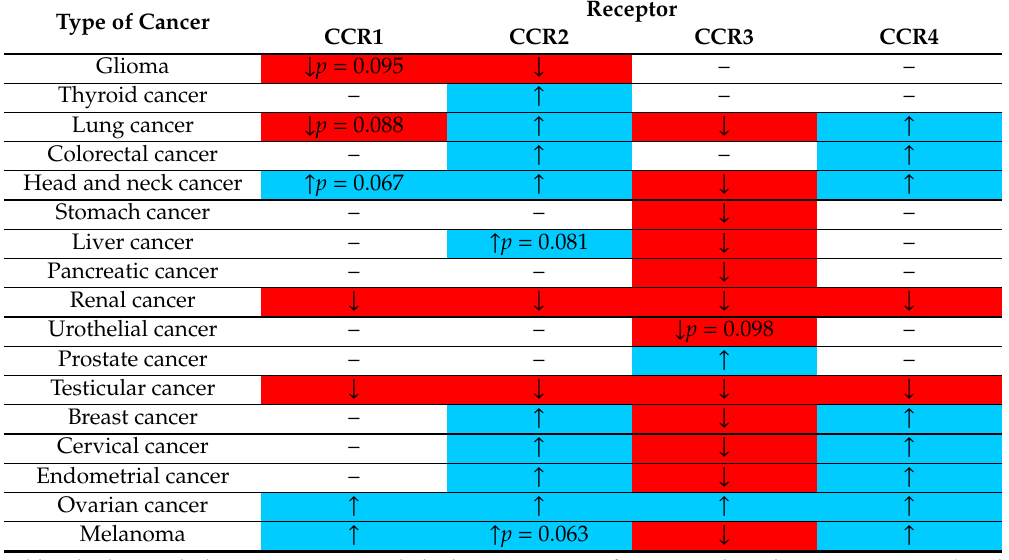
Table 2. E ff ects of increased expression of individual CC chemokine receptors discussed in this review on the prognosis of patients with various cancers according to “The Human Protein Atlas” (https: // www.proteinatlas.org / ) [8,9]. Receptor Type of Cancer CCR1